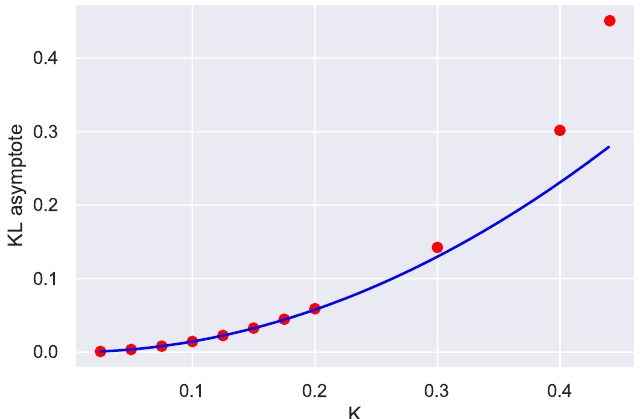
Figure 5: The asymptote of the normalized relative entropy of the 2d classical isotropic Ising model as a function of the nearest-neighbor coupling K in the range K ≤ K . The solid line is the function (53), while the red dots are the numerical c